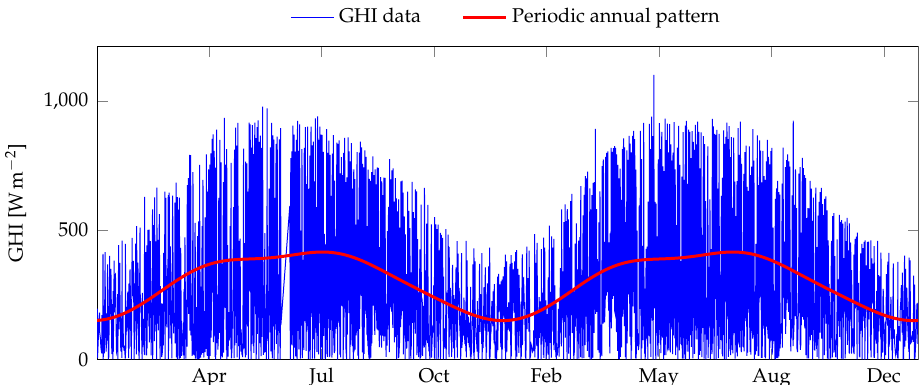
Figure 3. GHI data covering years 2016 and 2017. A seasonal pattern appears when considering data over several years. Measurements taken at PROMES-CNRS laboratory in Perpignan.